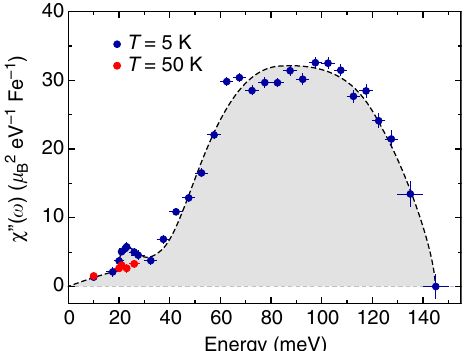
Fig. 4 Energy dependence of the dynamic local susceptibility of Li 0.8 Fe 0.2 ODFeSe at T = 5 and 50 K. The vertical and horizontal bars represent the standard deviation and integrated energy interval, respectively. The dashed curves are guides to the